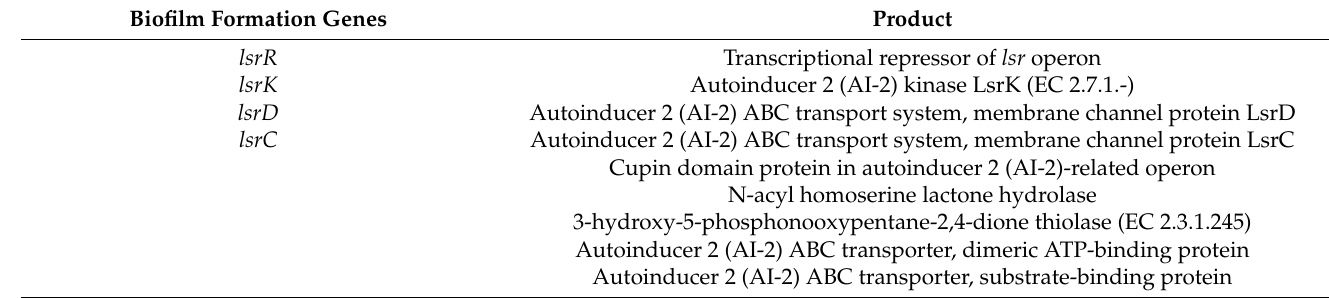
Table 4. Prediction of biofilm formation genes of Bacillus sp. B87 based on RASTtk in PATRIC. Biofilm Formation